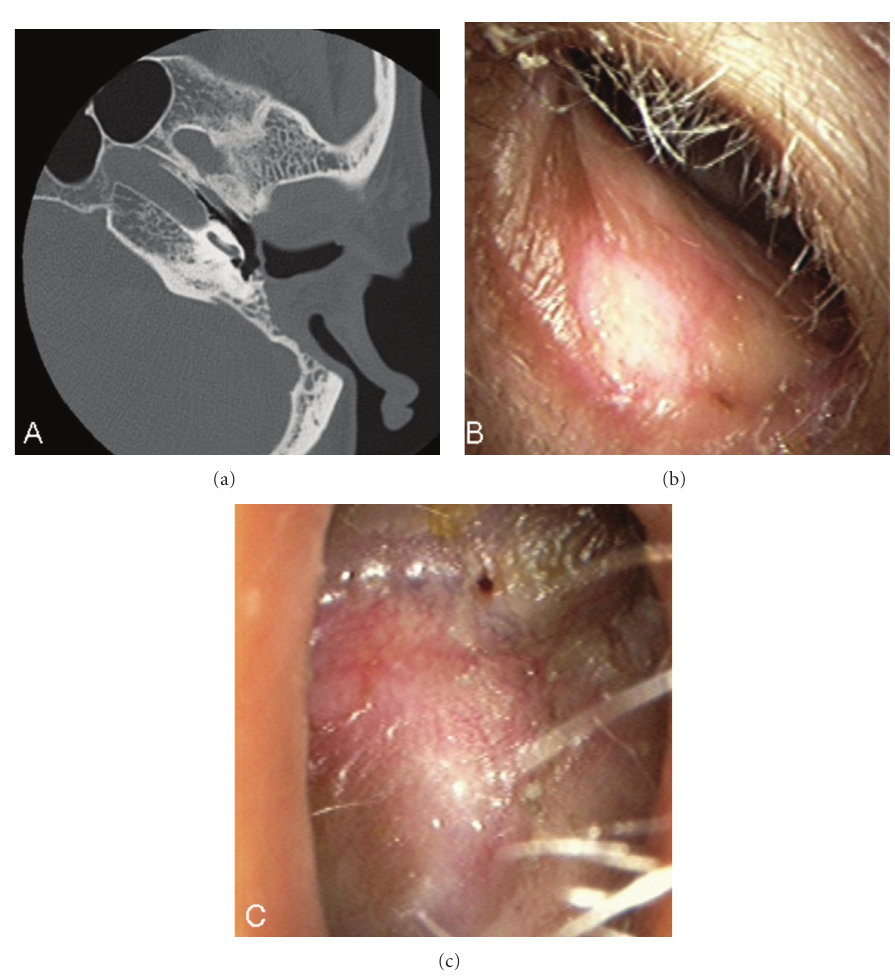
Figure 4: One-year postoperative findings in Case 2. (a) An axial CT image showed that the reconstructed EAC was kept in good shape, and no lateralization of the tympanic membrane was observed. (b and c) No stenosis or infection of the reconstructed external auditory canal was